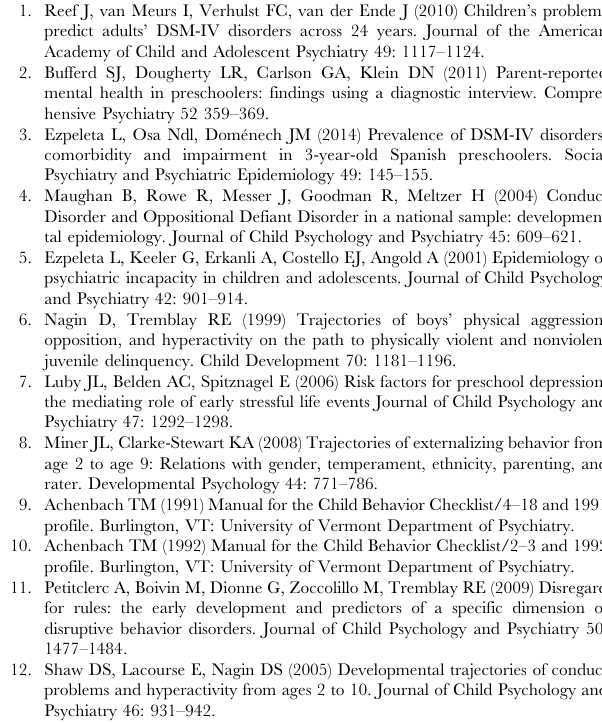
Figure S1 Study design. SDQ: Strengths and Difficulties